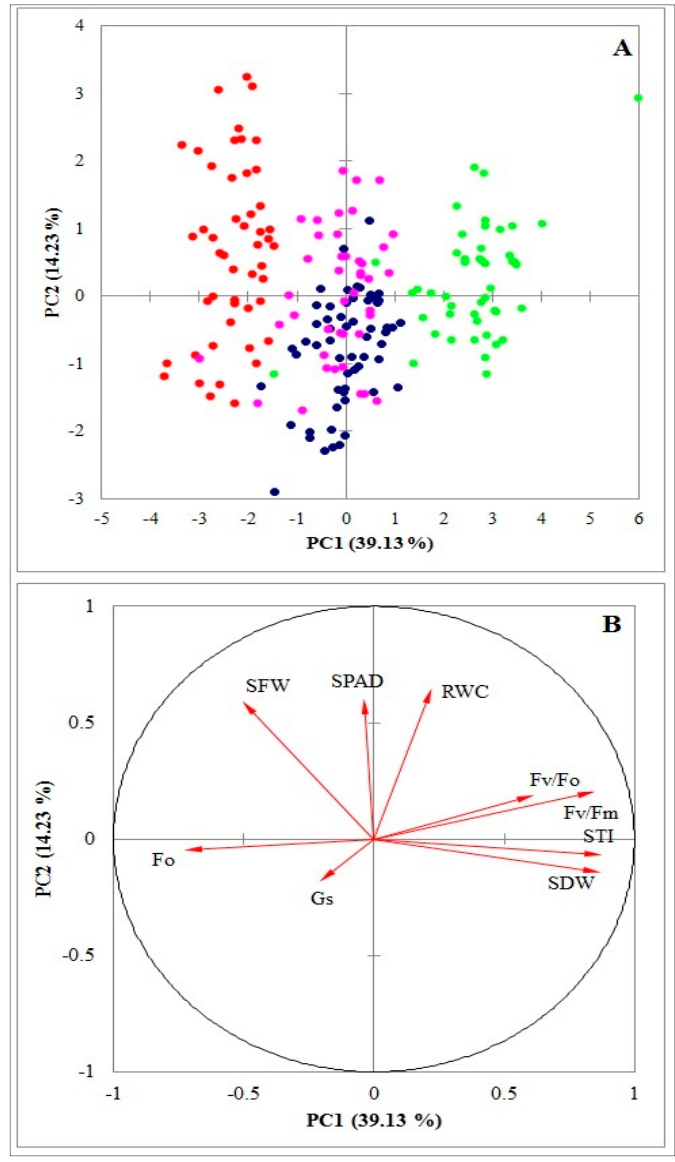
Figure 4. ( A ) Distribution of the 196 accessions possessing the D genome, based on the two first components under water deficit stress. Red, blue, green and pink circles indicate T. aestivum , Ae. tauschii , Ae. crassa and Ae. cylindrica accessions, respectively. ( B ) PCA-based biplot illustrating the relationships between the measured traits and STI. SPAD, Gs , Fo , Fv / Fo , Fv / Fm , SFW, SDW and STI indicate the relative chlorophyll content, stomatal conductance, initial fluorescence, maximum primary yield of photochemistry, maximum quantum efficiency, shoot fresh weight, shoot dry weight and stress tolerance index, respectively; PC, principal